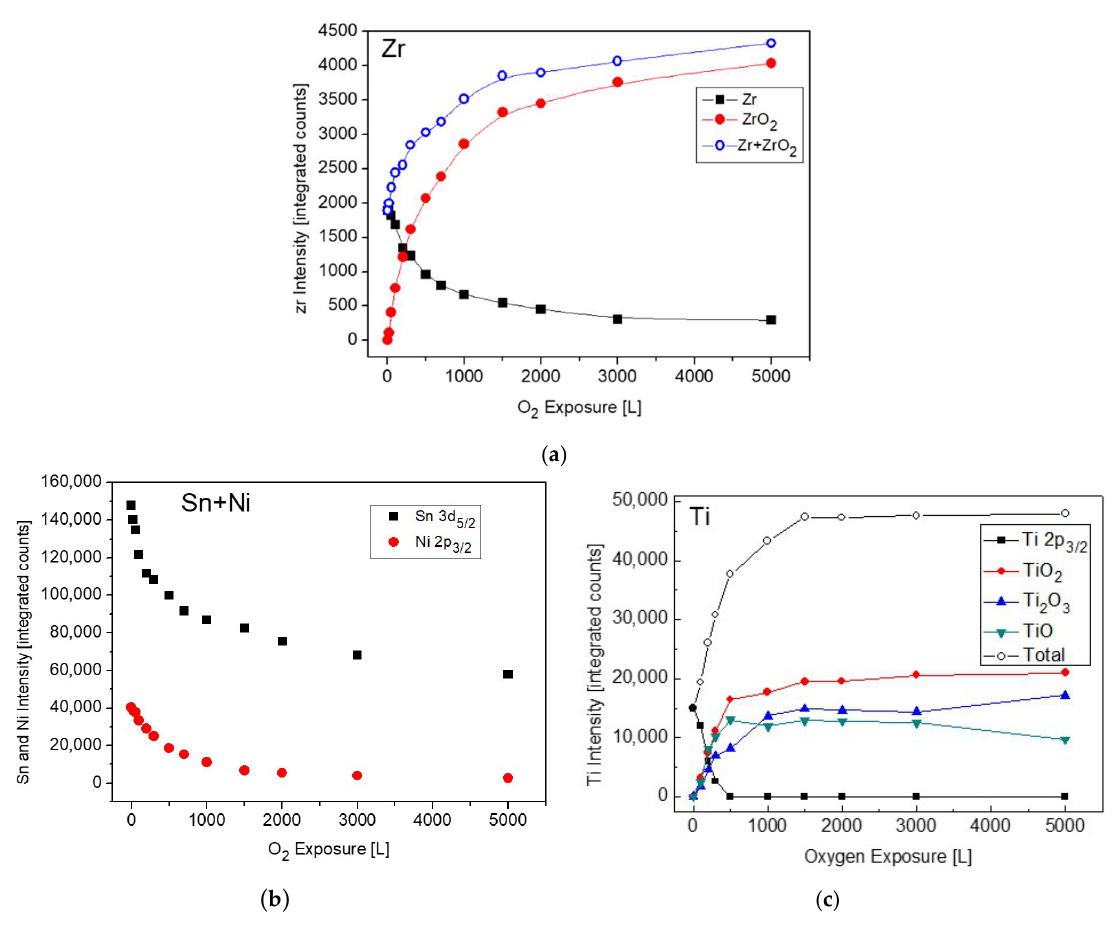
Figure 11. Intensity variation of: ( a ) Zr, ZrO 2 , ( b ) Ni and Sn and ( c ) Ti and its oxides, from [11] for comparison, during oxygen exposure at 1000 K.